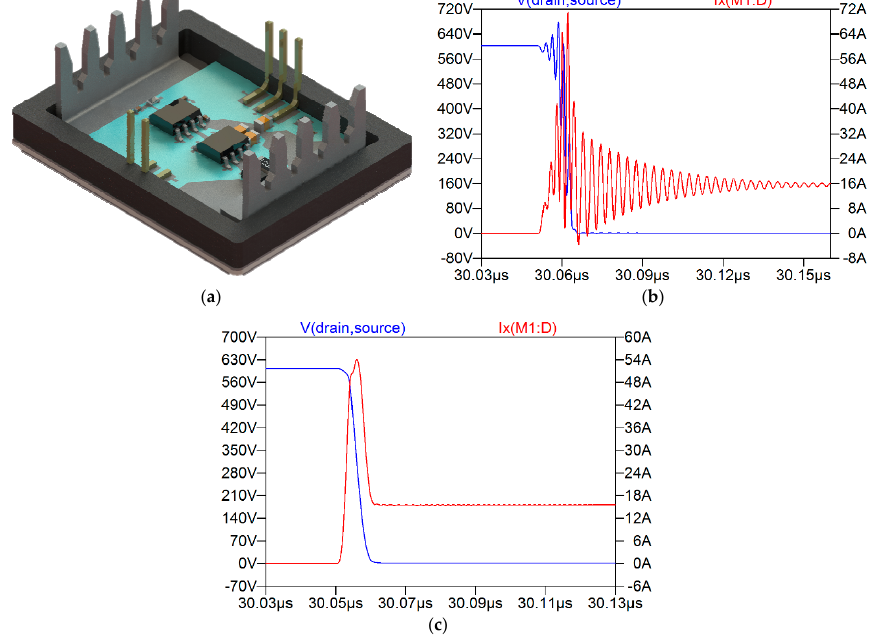
Figure 16. Flip-chip bonded integrated switch module, 2016, showing: ( a ) a rendering of the top side of the power module with the gate drive circuit; ( b ) the “turn-on” waveforms for a comparable wire bonded module; and ( c ) the virtually ripple free waveforms obtained by using a flip-chip wire-bondless